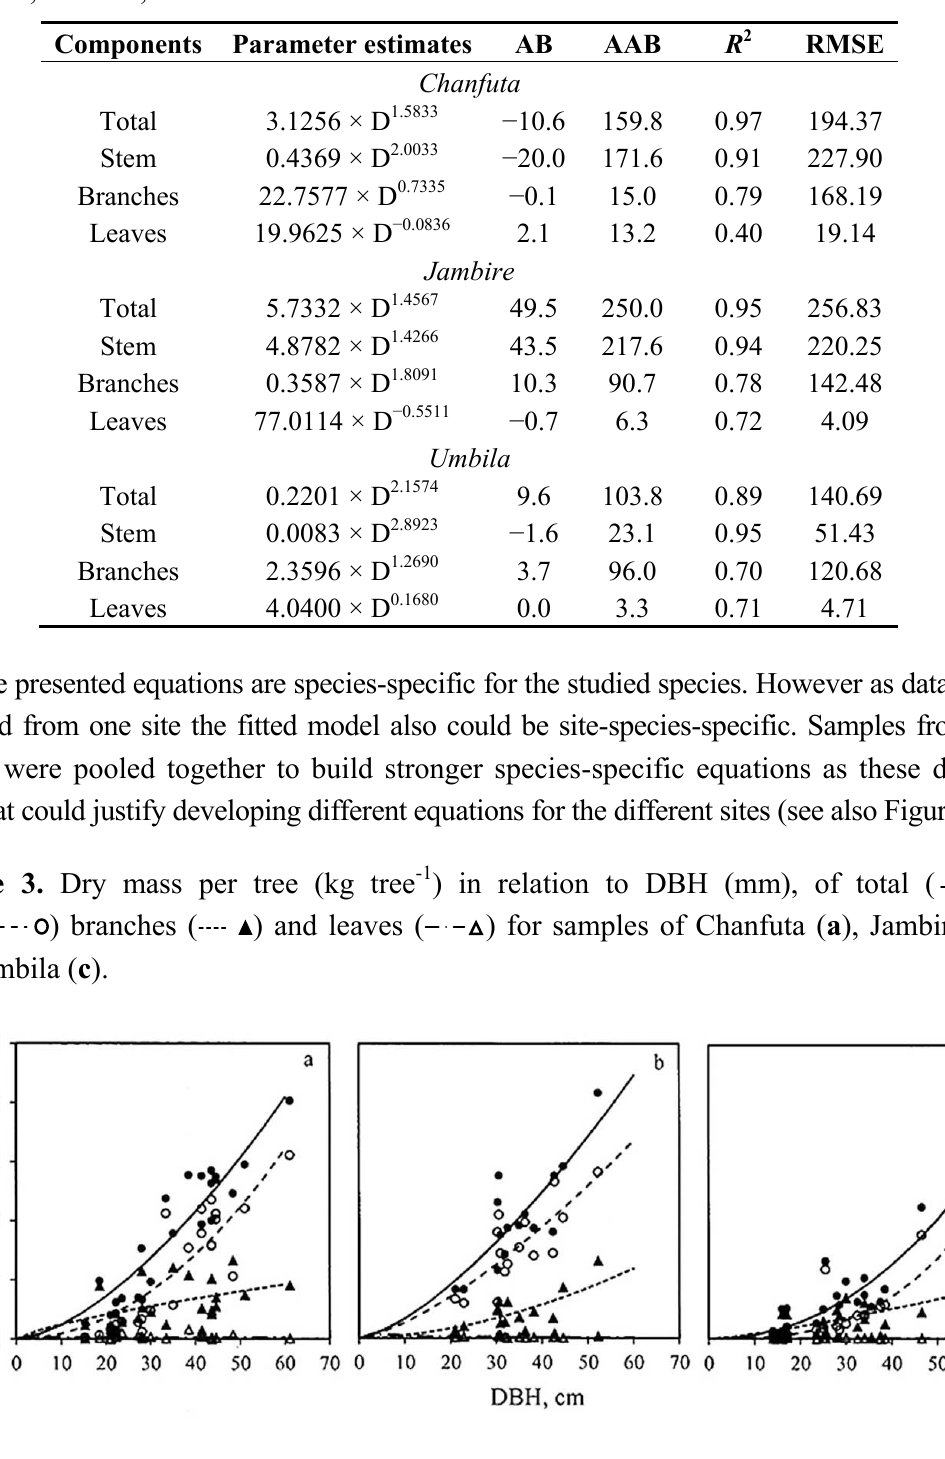
Table 5. Estimated parameters of the fitted power Equation (3) for AGB estimations of Chanfuta, Jambire, and Umbila.